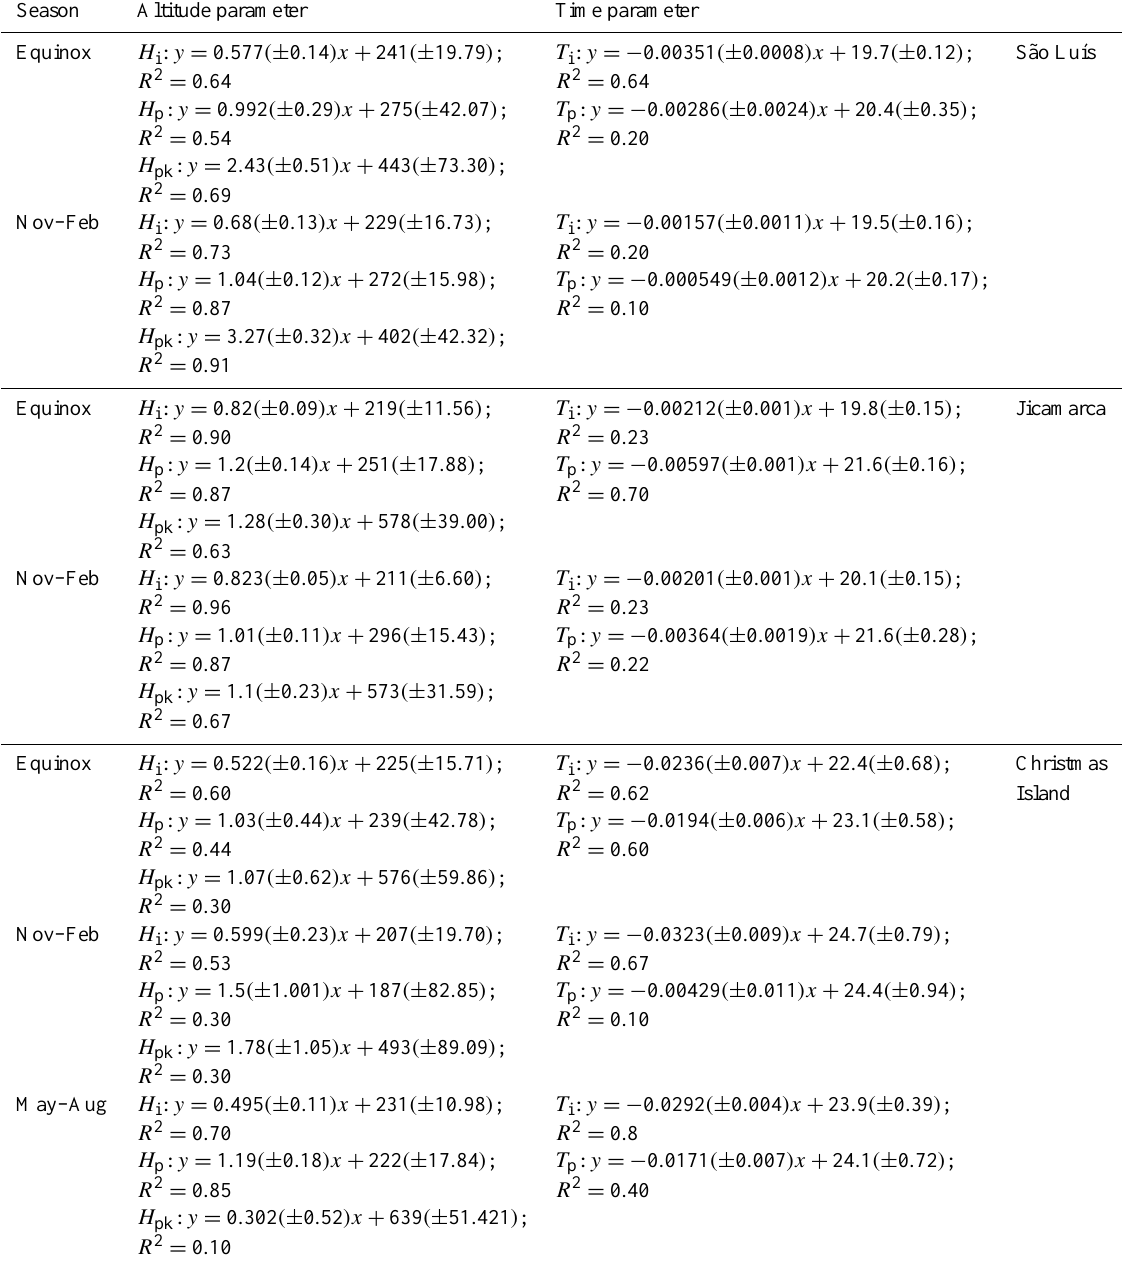
Table 4. VHF radar empirical model based on the linear relations of altitude and time parameters for São Luís, Jicamarca and Christmas Island equatorial